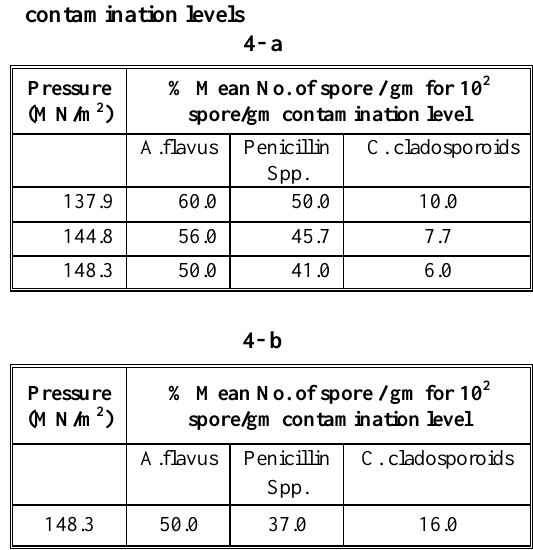
Table 4: effect of pressure on survival of different fungal spores expressed as a % in multivitamin and folic acid tablets using 10 2 spore and